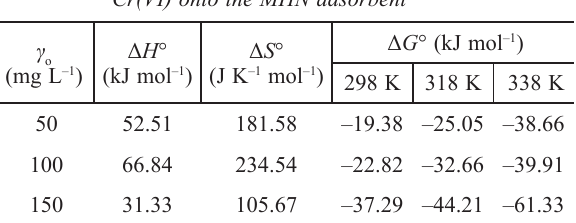
Table 2 – Thermodynamic parameters for the adsorption of Cr(VI) onto the MHN adsorbent γ o (mg L –1 )